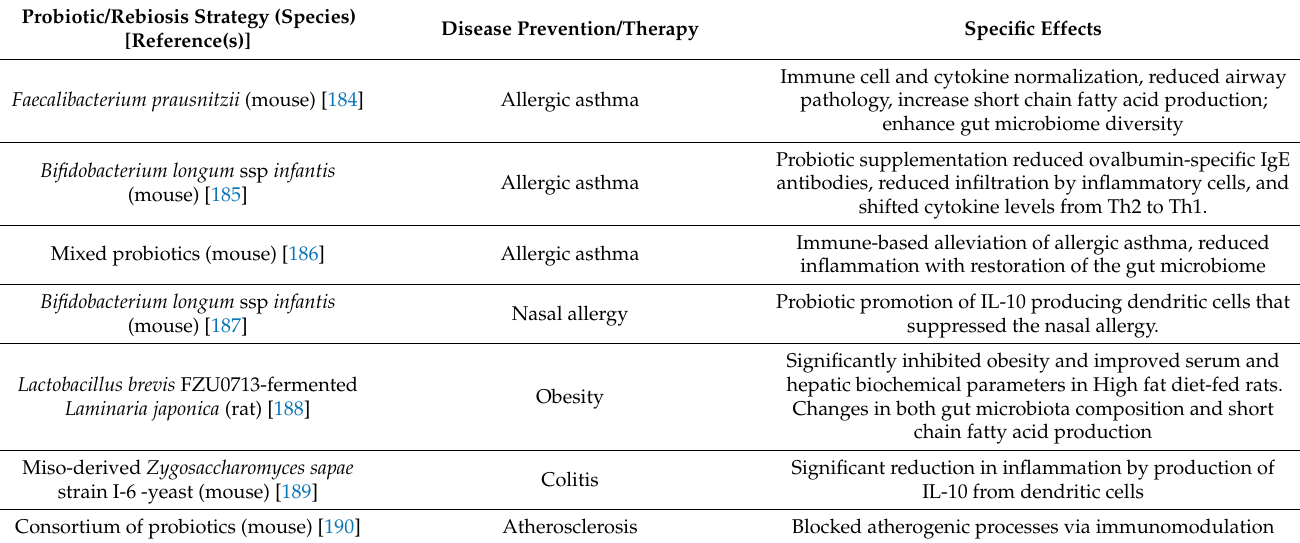
Table 5. Examples of recent preclinical trials and research with